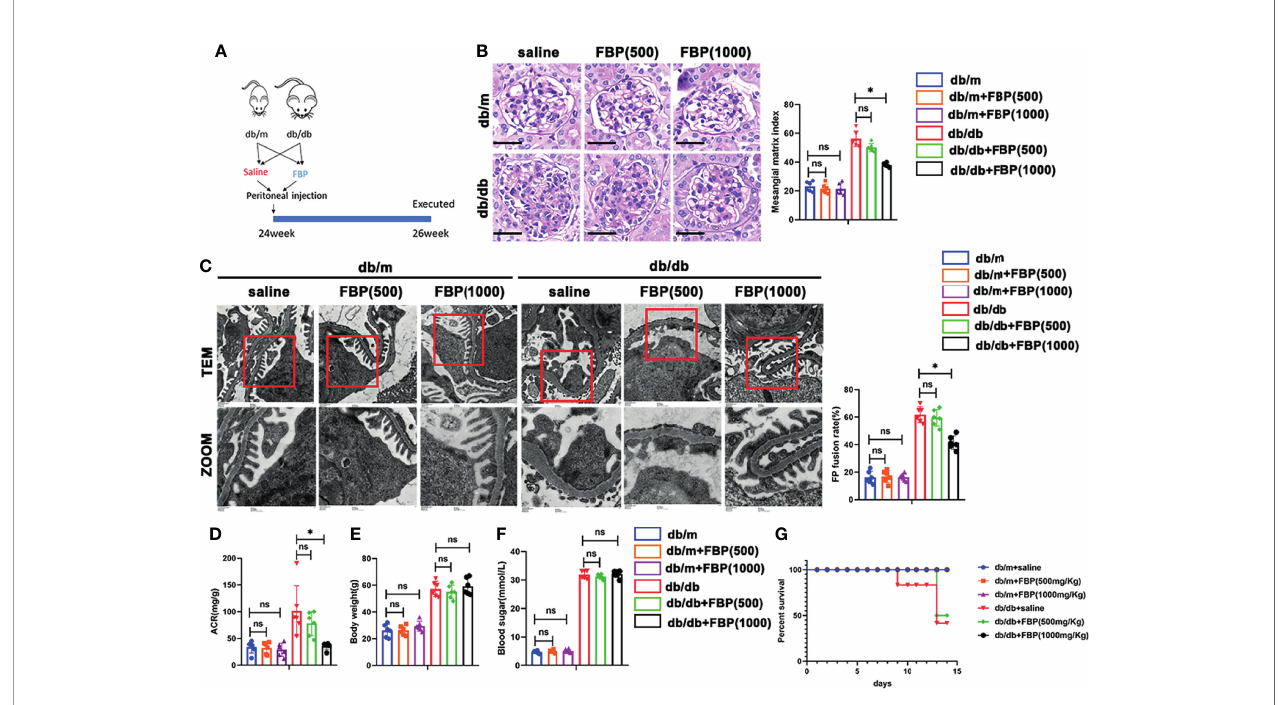
FIGURE 9 | FBP protected db/db mice from foot process fusion in podocytes. (A) Schematic diagram of FBP administration in advanced db/db mice. (B) Representative microscopy images and quanti fi cation of PAS staining of kidney sections from individual group (original magni fi cation ×400). (C) Representative transmission electron microscopy images of the ultrastructure of capillary loops in each group (original magni fi cation×8,000, ×12,000). (D) Quantitative of ACR (albumin-to-creatinine ratio) in each group. (E) Body weight of mice in each group. (F) Blood sugar of mice in each group. (G) Survival curve of db/m and db/db mice treated with FBP over time. For all fi gures, n=6 independent experiments/group. * P < 0.05, ns, No signi fi cance. Scale bars: 20 µm, FBP, fructose-1,6- bisphosphate; 500, 500mg/kg/d; 1000,